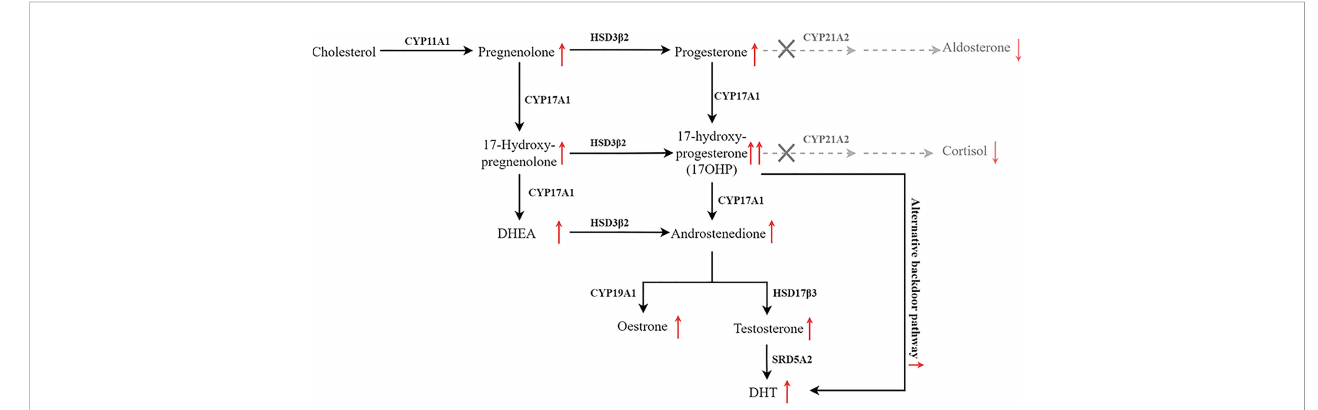
FIGURE 1 Pathway of steroid biosynthesis in the adrenal cortex. 21-hydroxylase de fi ciency results in decreased cortisol and aldosterone, and elevated cortisol precursors and adrenal androgens. The grey denotes de fi cient pathways.